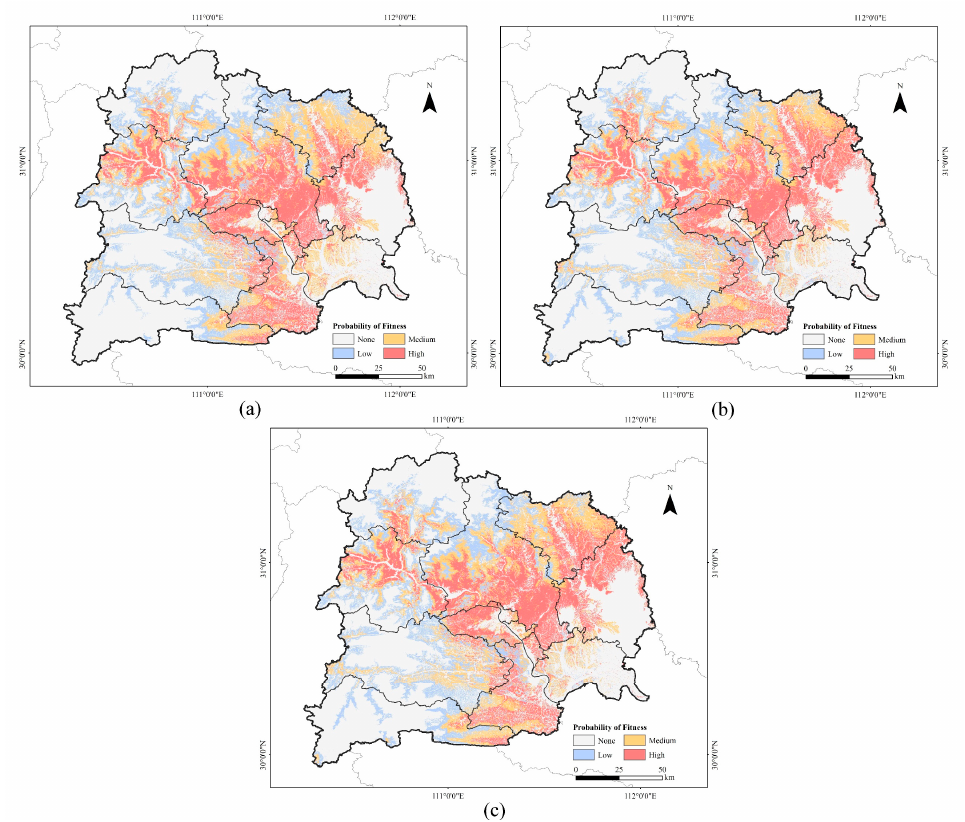
Figure 5. Prediction of potential suitable area for PWD in Yichang City in three groups. ( a ) The prediction result of Maxent model with non-landscape factors; ( b ) the prediction result of Maxent model with non-human factors; ( c ) the prediction result of Maxent model with nature factors.